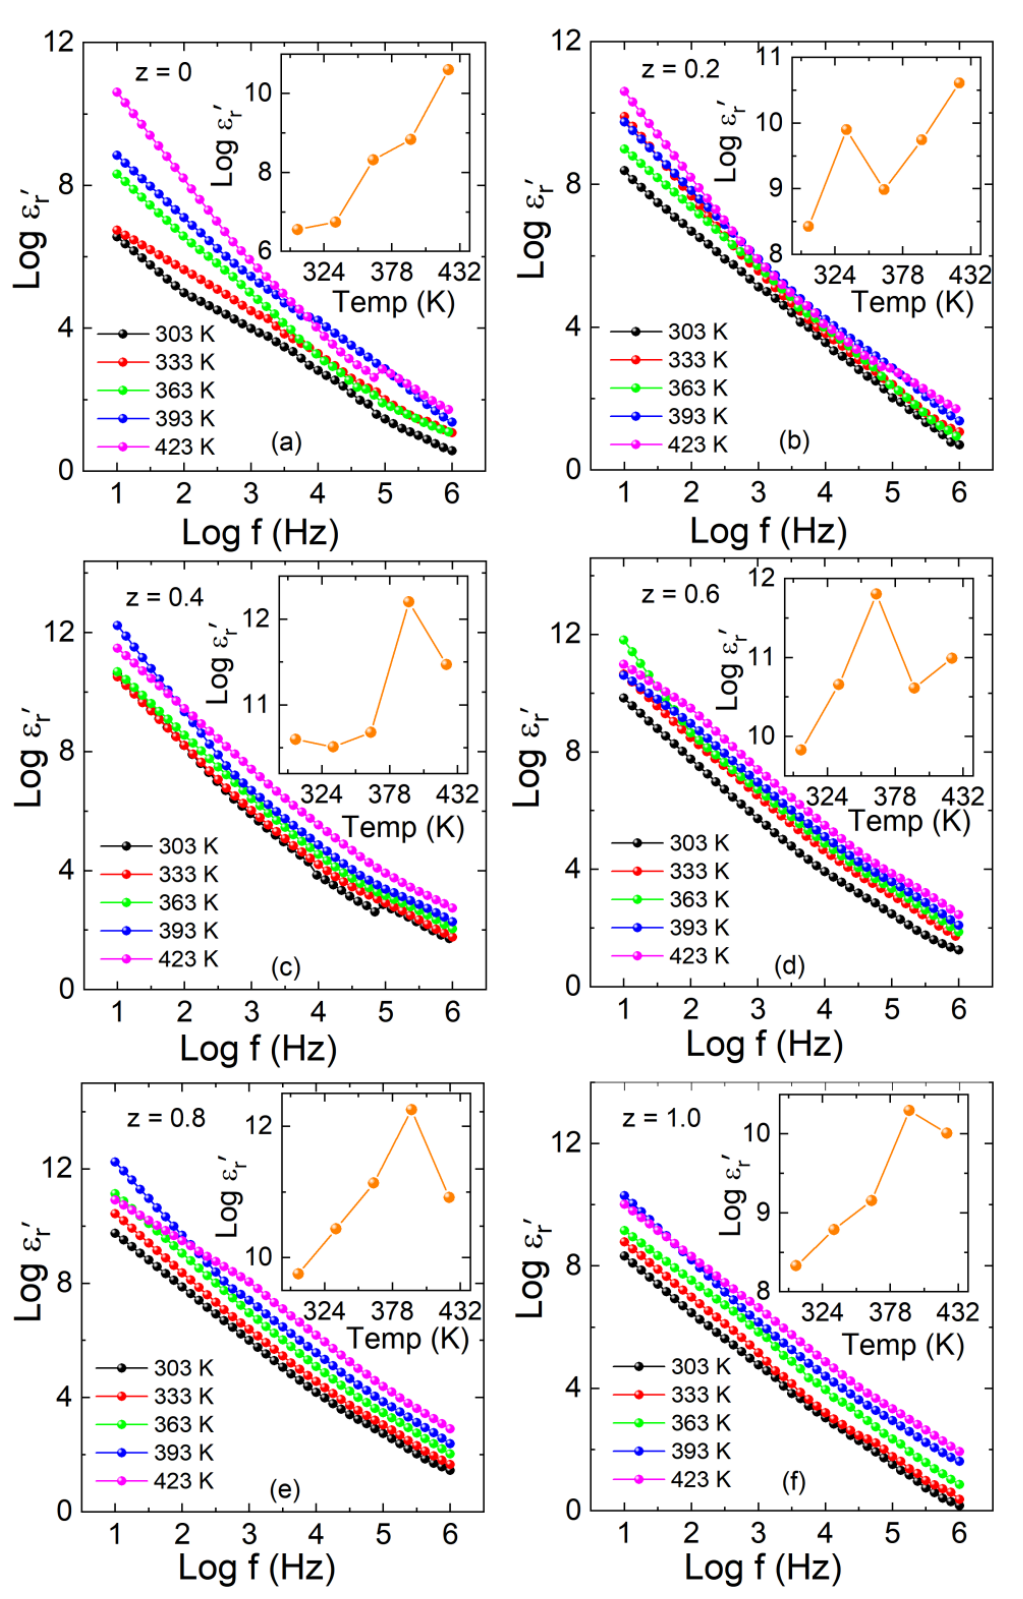
Figure 7. ( a – f ) The real part of the dielectric constant ( Log 𝜀 𝑟′ ) versus Log f graph for La 2 Co 1−z Fe z MnO 6 . Inset of ( a – f ) represents the temperature-dependent real part of each plot.